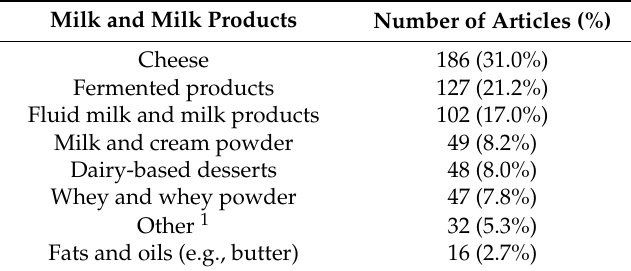
Table 2. Data for milk categories.